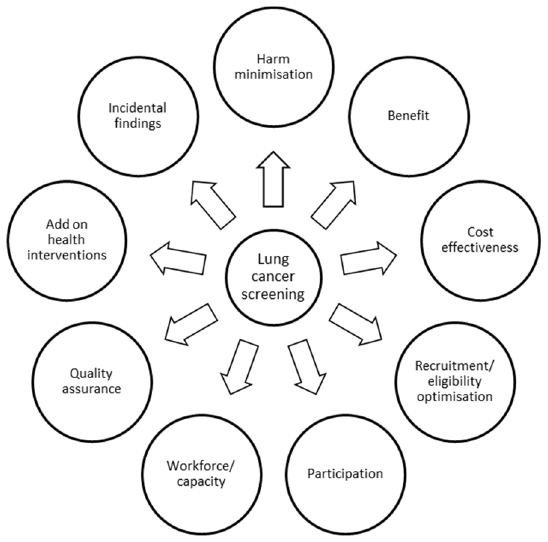
Figure 1. Summary of areas to be addressed prior to lung cancer screening implementation.